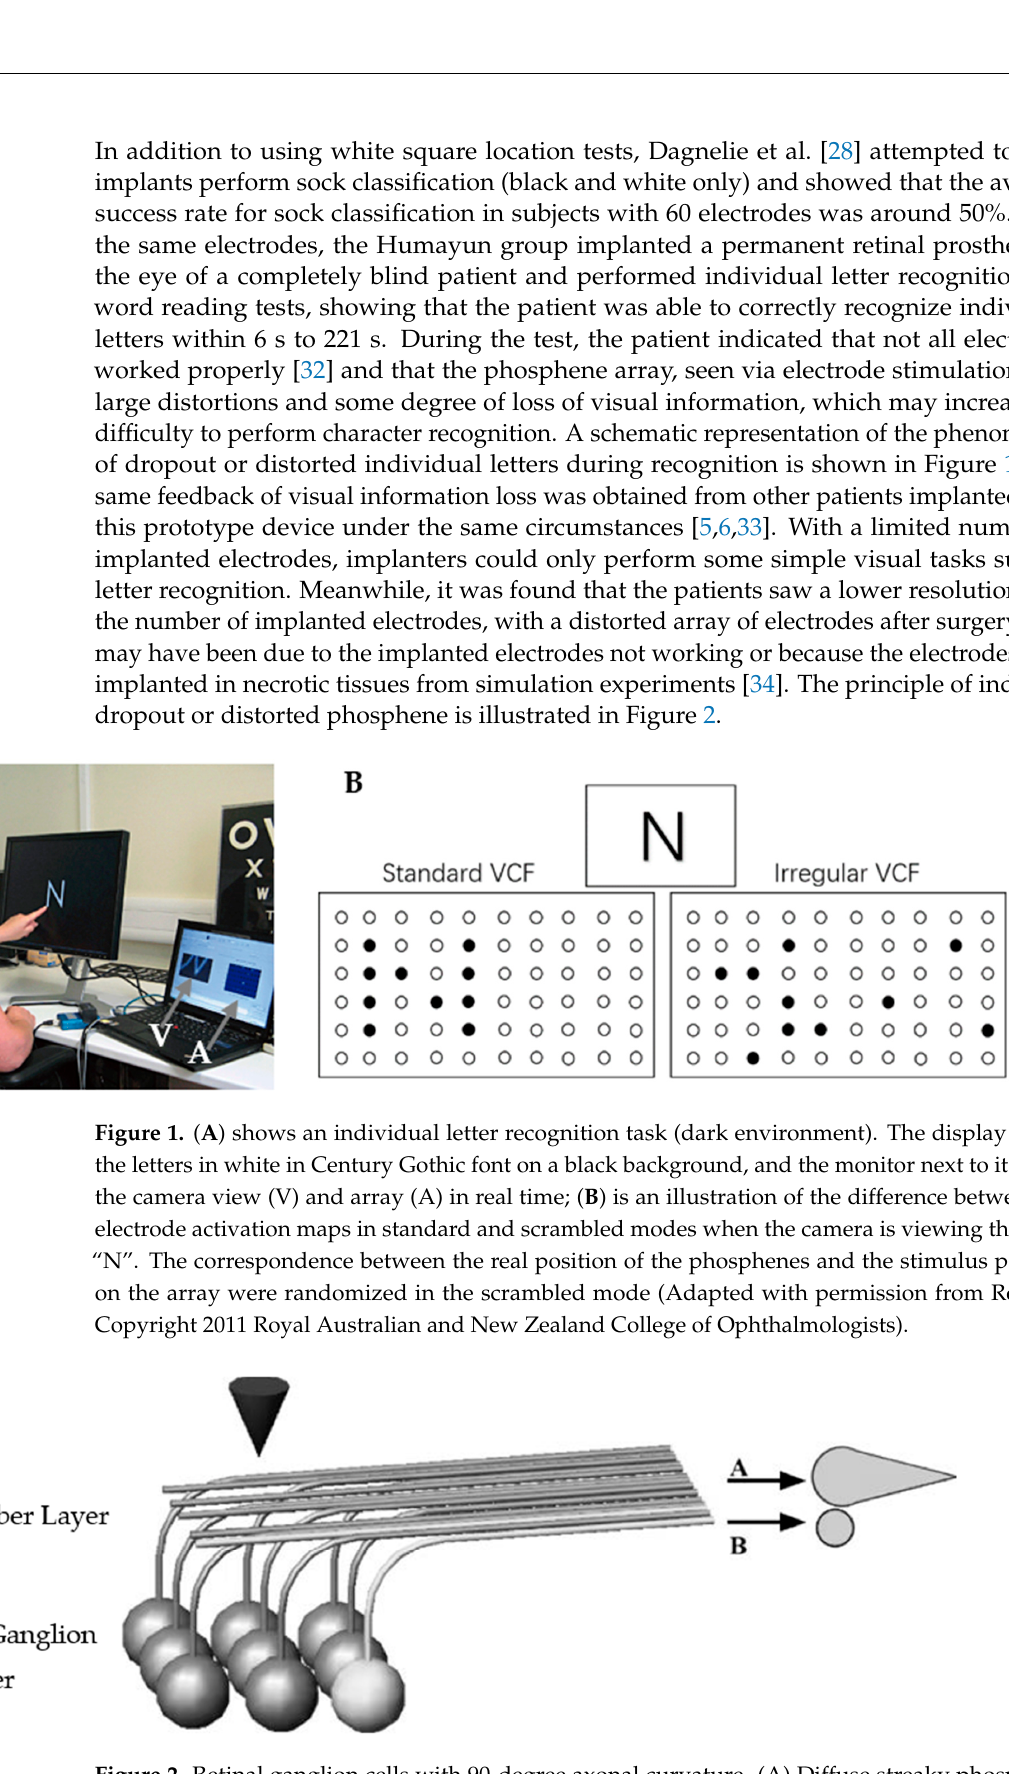
Figure 2. Retinal ganglion cells with 90-degree axonal curvature. (A) Diffuse streaky phosphenes produced by stimulation of distant retinal ganglion cells through the overlying axons. (B) Direct stimulation of retinal ganglion cells beneath electrodes produces punctuate phosphene (cited from